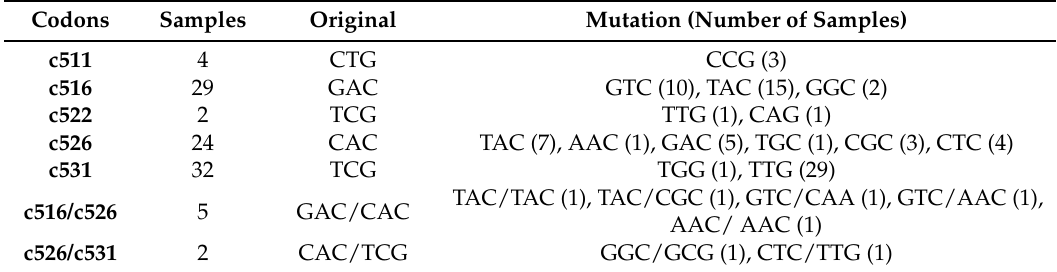
Table 3. Specific mutations found in codons of rpoB gene by 9G DNAChip.